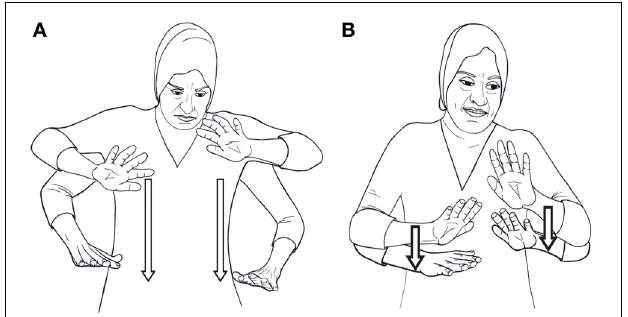
FIGURE 6 | (A) SIT (KQSL), non-small. (B) SIT (KQSL), small.